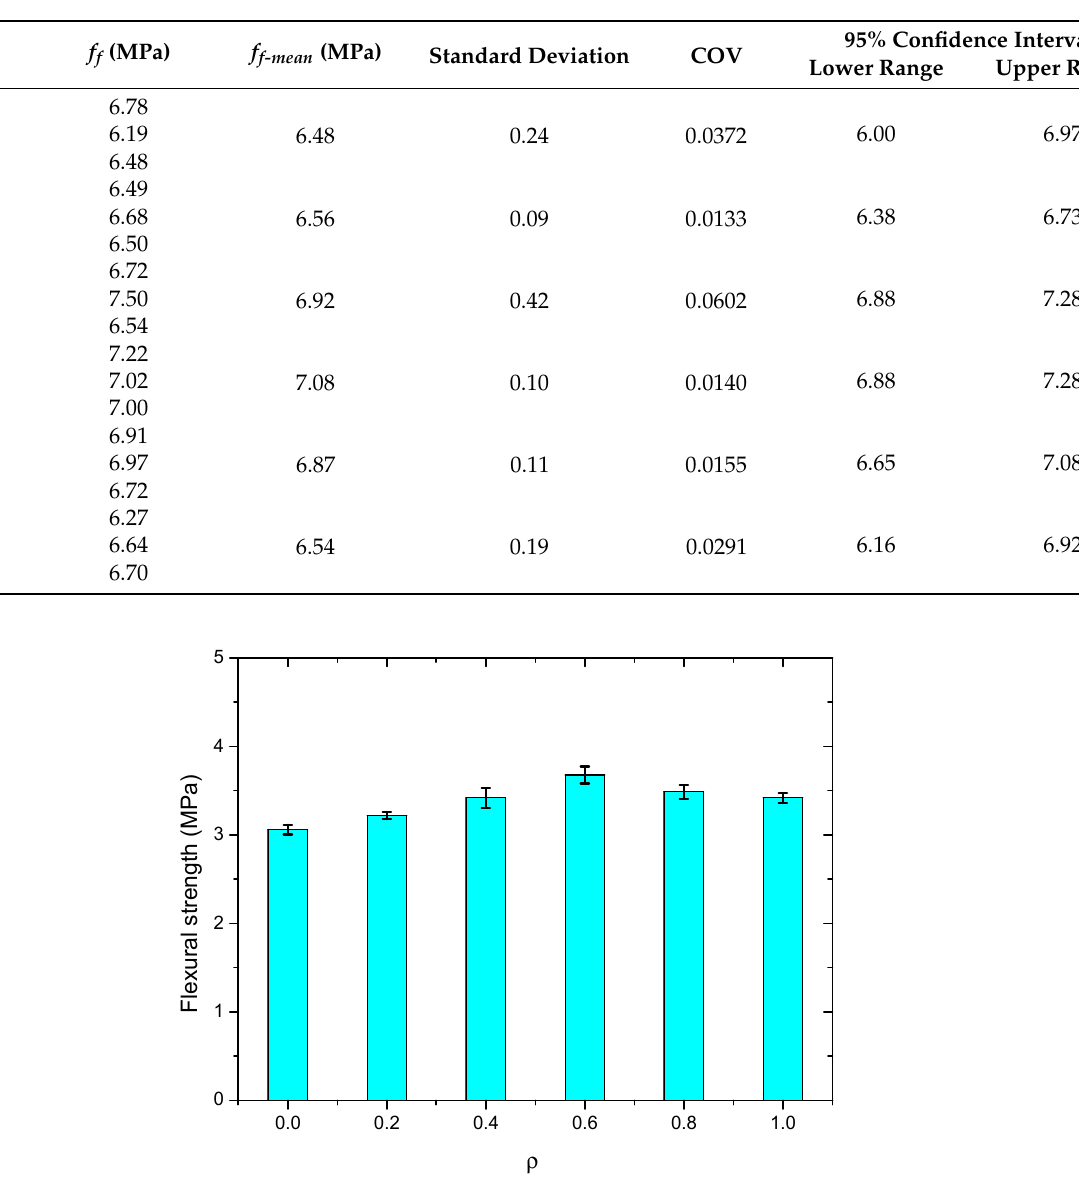
Figure 23. Comparison between numerical and test results: f f . ( a )